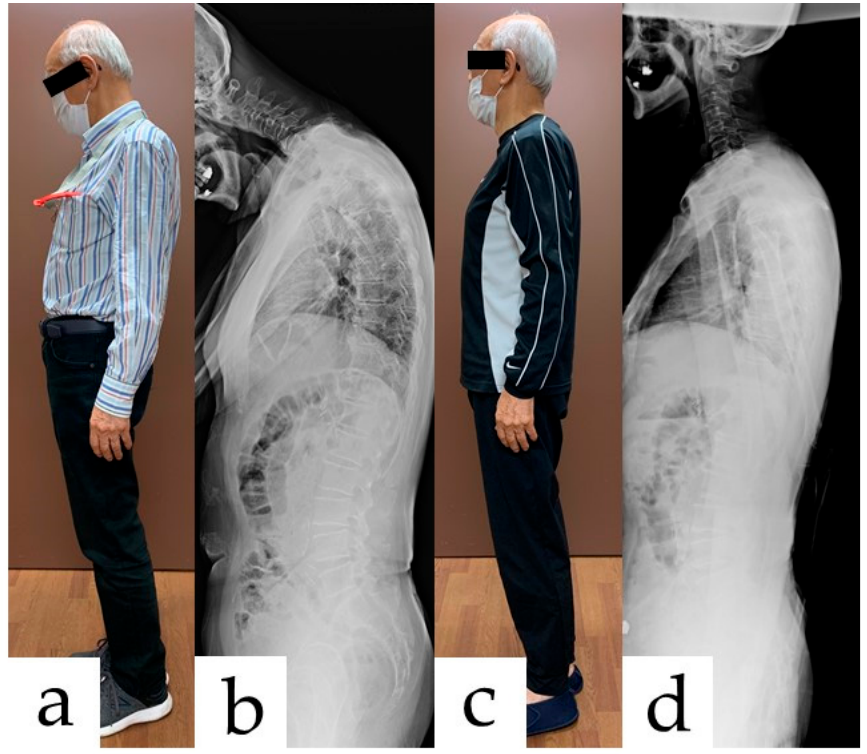
Figure 1. Pre and post-rehabilitation posture. Before rehabilitation: ( a ) lateral view of the photograph and ( b ) standing radiograph. Two weeks after rehabilitation: ( c ) lateral view of the photograph and ( d ) standing radiograph.